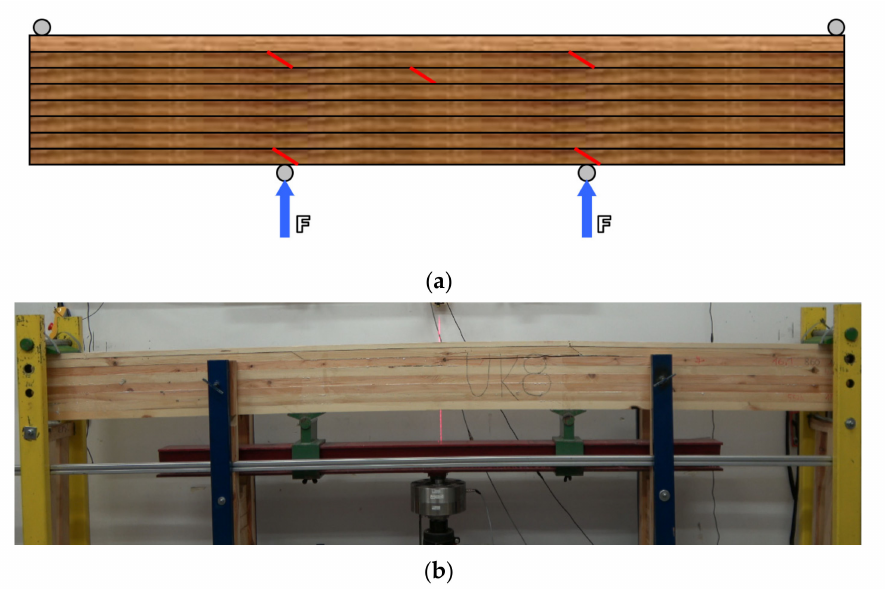
Figure 2. Measuring device: ( a ) the scheme of the manufactured beam, ( b )